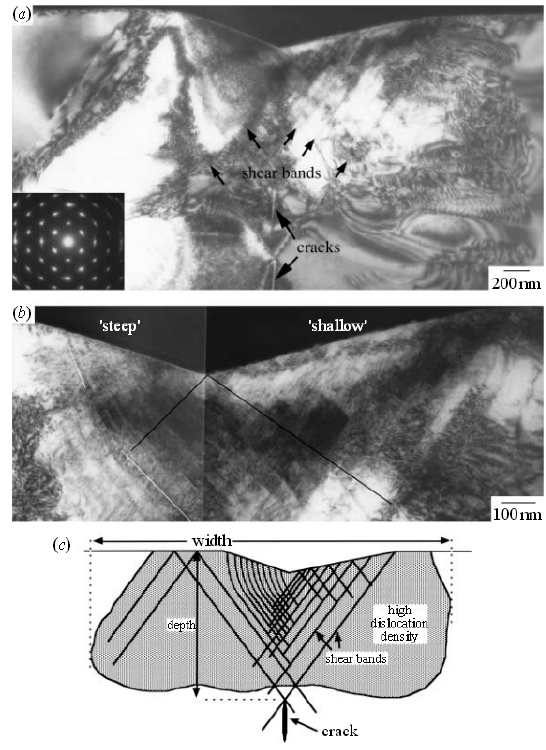
Figure 14. ( a ) Bright field image of an 80 mN indent in spinel with an inset diffraction pattern; ( b ) Bright field image of a 60 mN indent in spinel showing the region of shear bands under the indent more clearly; ( c ) Schematic illustrating the principle components of the deformation pattern in spinel [42].